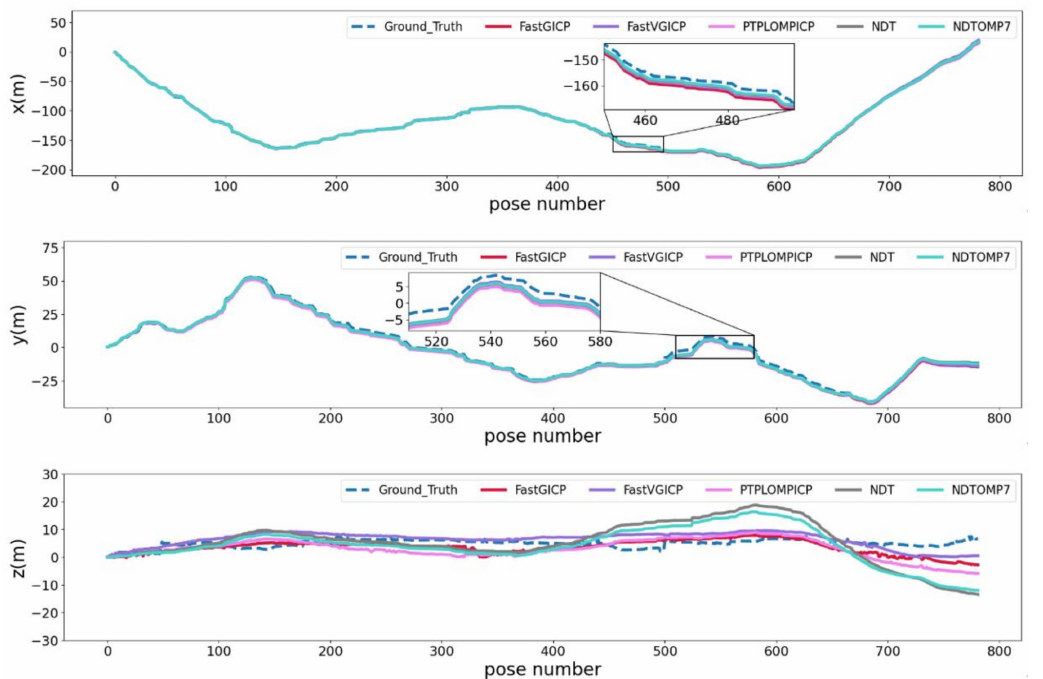
Figure 5. Comparison of output trajectories of registration algorithm in x, y, and z directions.